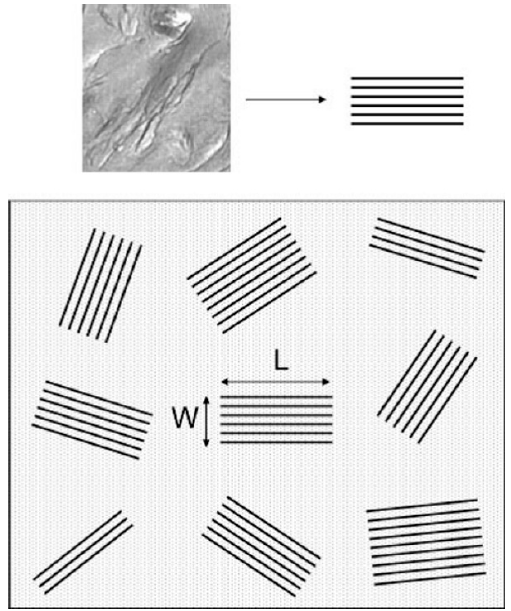
Figure 9. Morphological model of PS/VDAC-MMT nanocomposite system [113]. = 5 nm. The disk thickness